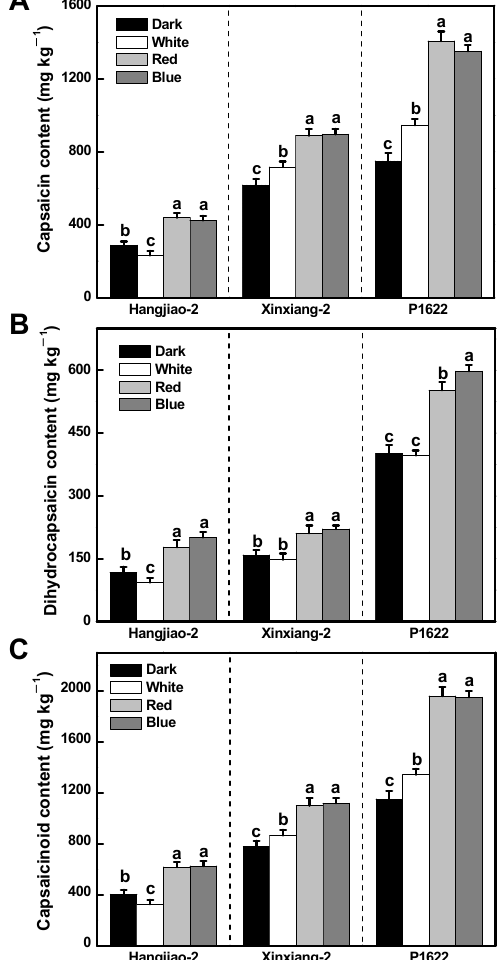
Figure 1. Effect of light quality on capsaicin ( A ), dihydrocapsaicin ( B ), and capsaicinoid ( C ) content in pepper fruits of three cultivars. Results are shown as mean ± SE of triplicate samples. Means denoted by the same letter were not significantly different at p < 0.05 according to Tukey’s test.